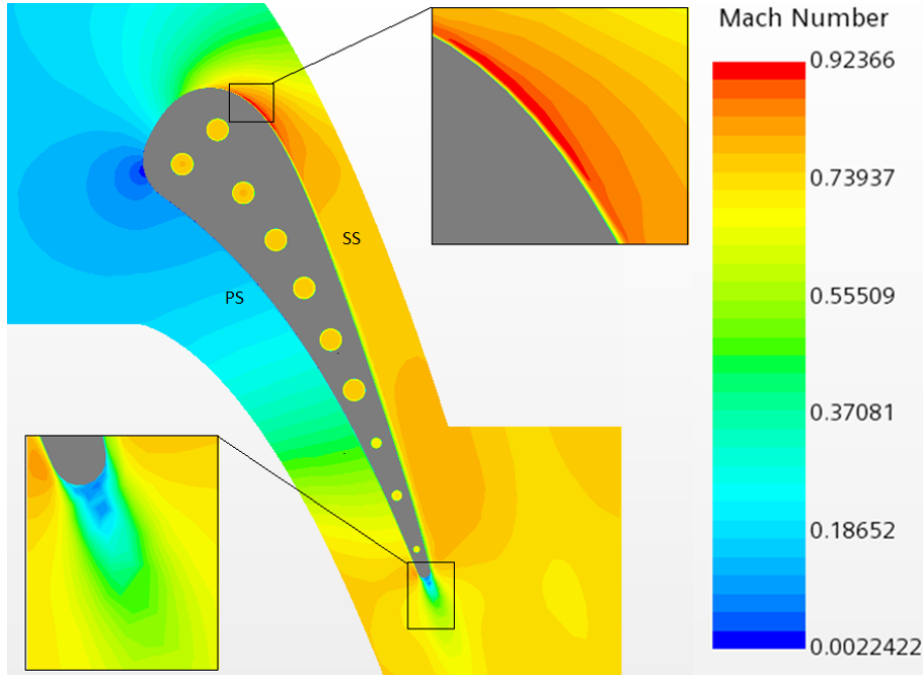
Figure 7. Contours of the Mach number on the mid-span plane, including enlarged views of the transition regions on the suction side and near the trailing